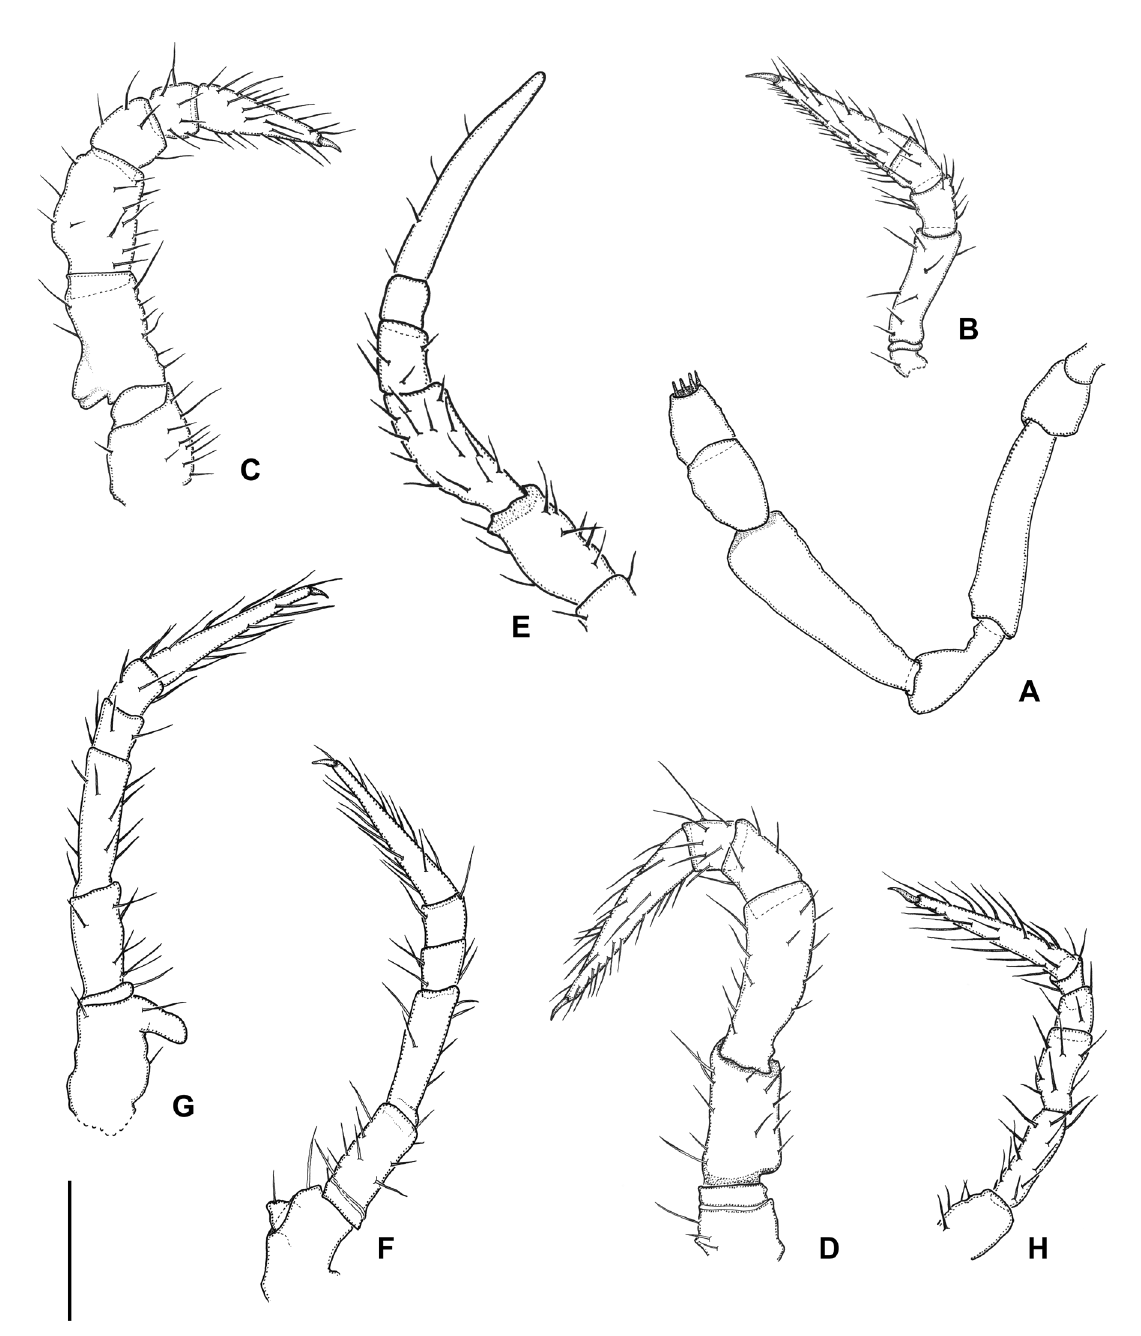
Fig. 2. Non-gonopodal characters of Anamastigona cypria sp. nov., ♂♂, paratypes. A . Antenna (setae omitted). B . Leg 1. C . Leg 3. D . Leg 5. E . Leg 7 (claw broken off). F . Leg 10. G . Leg 11. H . Leg 24. Scale bar = 0.2